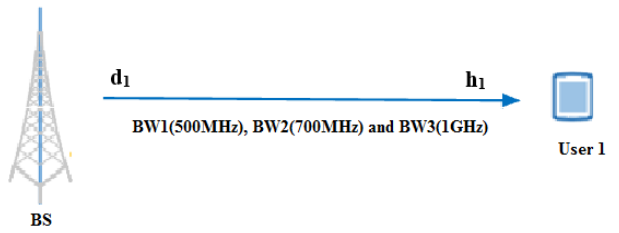
Figure 5. Wireless network consisting of one user NOMA with different bandwidths